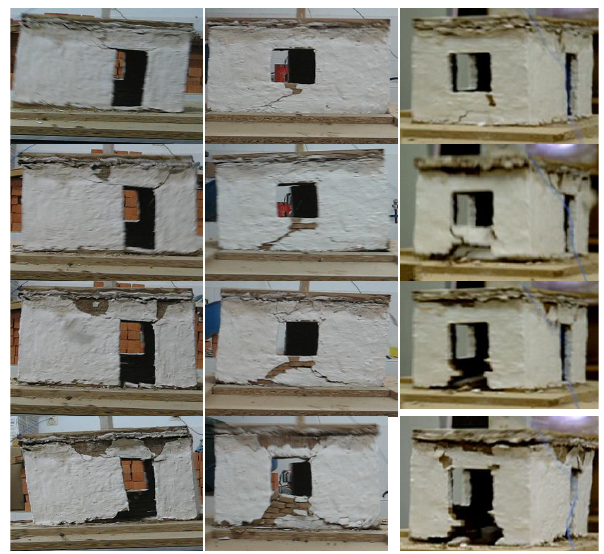
Fig. 10 Failure sequence of specimen CF1 Fig. 10. Failure sequence of specimen CF1.